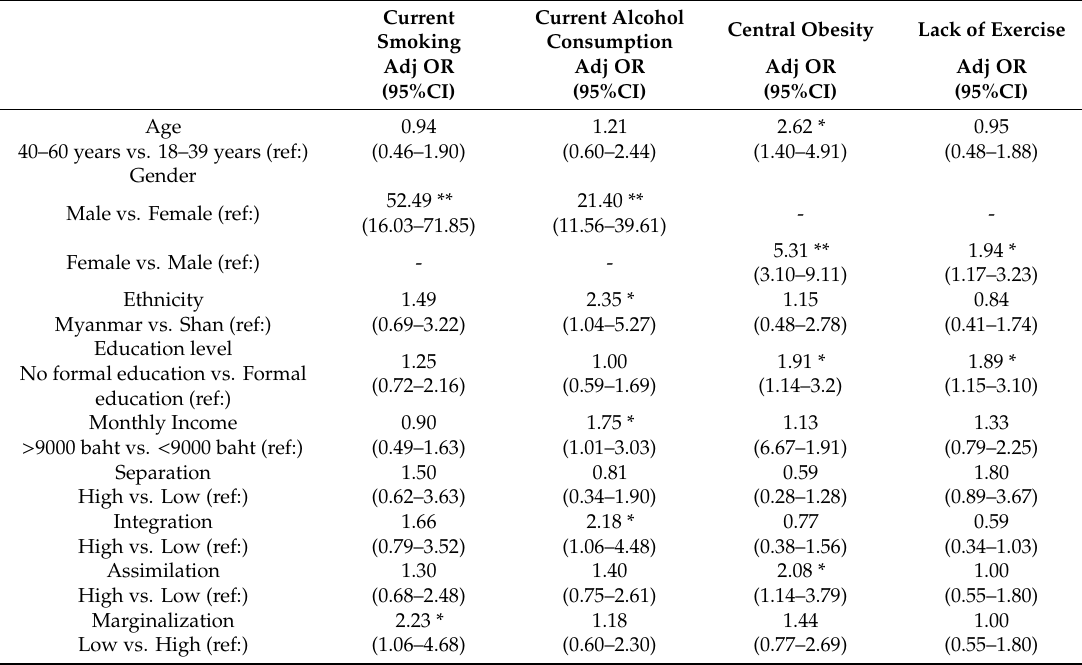
Table 3. Health risk behaviors and associated